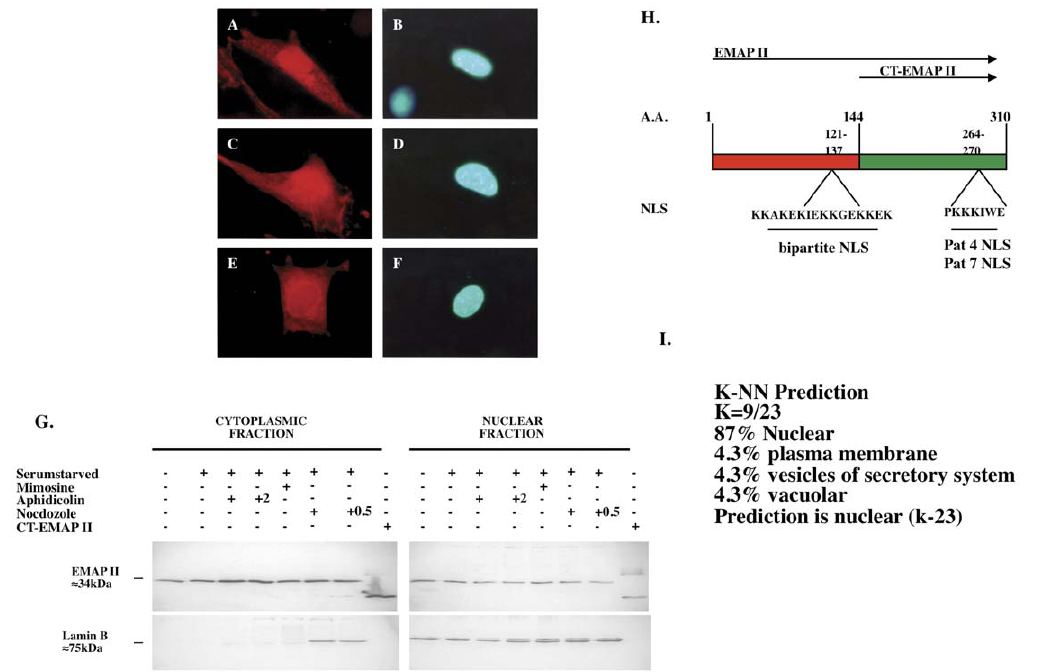
Figure 4. EMAP II undergoes nuclear/cytoplasmic partitioning during cell cycle. EMAP II distribution was assessed in chemically synchronized cell populations. Immunofluoresence indicated EMAP II expression is predominately nuclear in G0 (A,B) and S (C,D) phase, whereas in G2M (E/F) nuclear EMAP II is reduced. Western blot analysis (G) of isolated nuclear and cytoplasmic fractions indicates EMAP II expression is maintained in both compartments through out cell cycle (these experiments were performed 4 times). PSORT II analysis determined there were three classical types of nuclear localizing sequences (NLS): pat4, pat7, and a bipartite NLS (H). Proteins K and R composition predicts that 87% of EMAP II is subcompartmentalization to the nucleus EMAP II’s (I). Magnification in A–F: 1000 6